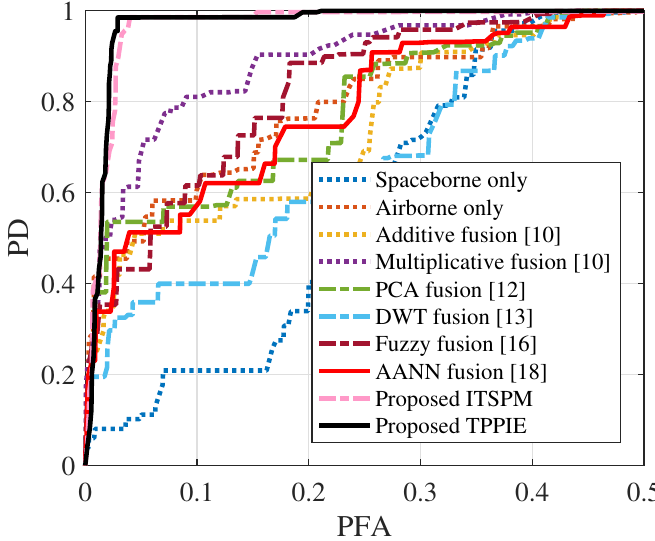
Figure 12. ROC curves of different methods for Experimental Scene 1. When pursuing a relatively high PD (e.g., larger than 0.98), the PFAs of the proposed ITSPM and TPPIE fusion methods were far less than those of the other methods, including spaceborne image processing, airborne image processing, additive fusion [10], multiplicative fusion [10], PCA fusion [12], DWT fusion [13], fuzzy fusion, and AANN fusion [18].